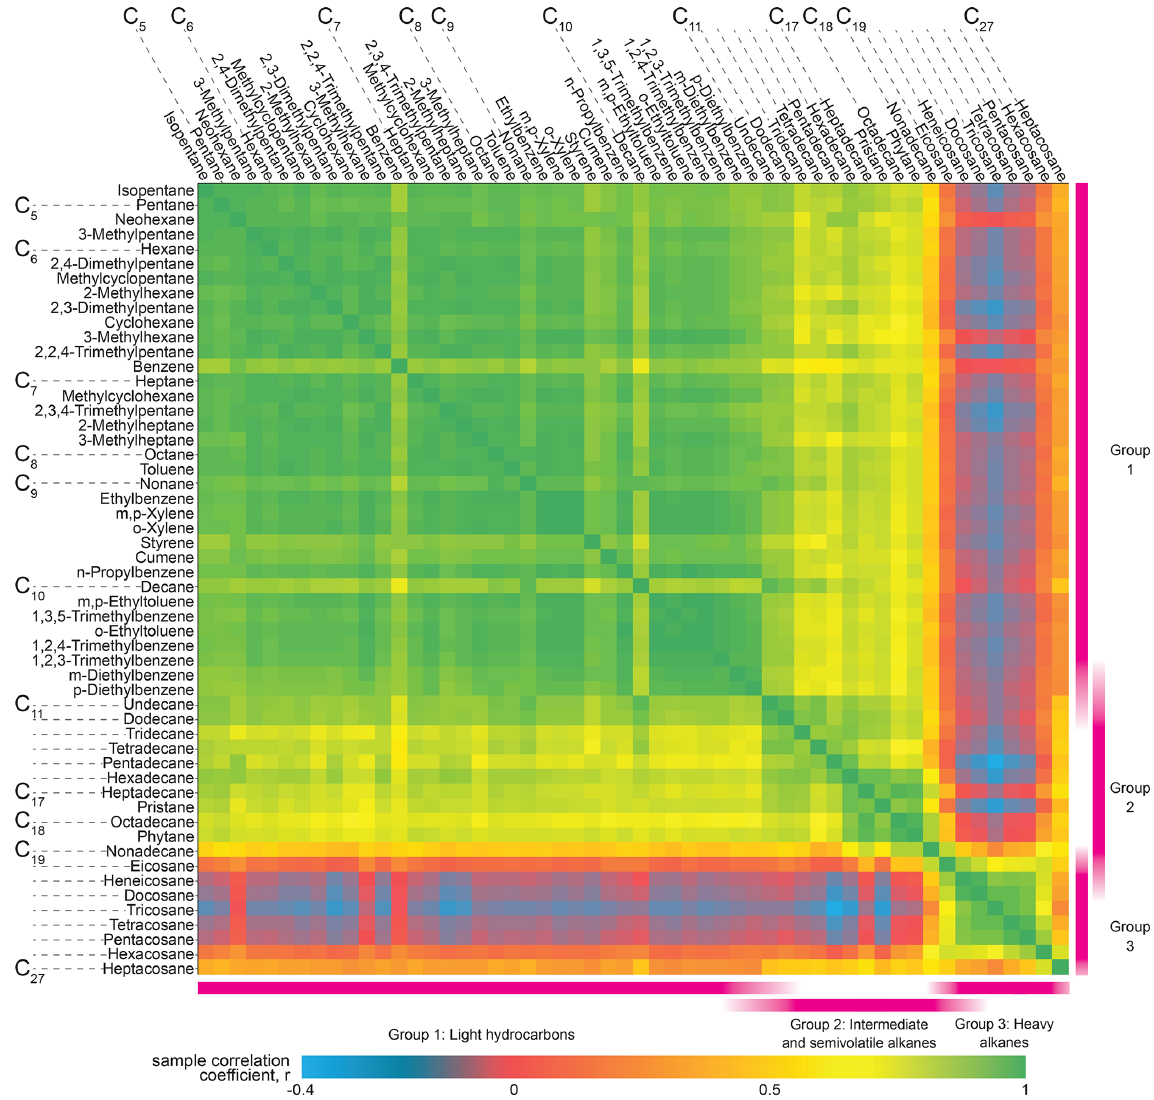
Figure 9. Pearson’s R correlation matrix for a suite of petroleum-derived compounds observed by cTAG in Livermore, California, between 11 April and 21 April 2018, ordered by volatility. Two distinct groupings emerge from C 5 alkane-equivalent volatility to about C 11 and C 20 to C 26 , with a third less distinct but still prominent grouping from approximately C 11 to C 19